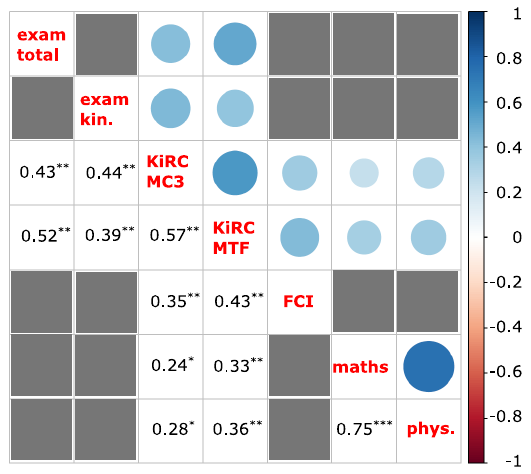
FIG. 3. KiRC test correlations. Note that MC3, MTF, and FCI measures were taken at the same time (pre-instruction). Math and physics scores reflect achievements in school, the exam score refers to performance on the total exam taken at the end of the semester (performance on one exam problem dealing with kin- ematics exclusively was investigated separately). Pearson ’ s r is reported ( df ¼ 83 , (cid:2) p < 0 . 05 , (cid:2) (cid:2) p < 0 . 01 , (cid:2) (cid:2) (cid:2) p < 0 . 01 ) — the p value refers to correlations significantly greater than zero. Irrelevant correlations have not been calculated and are indicated by the gray